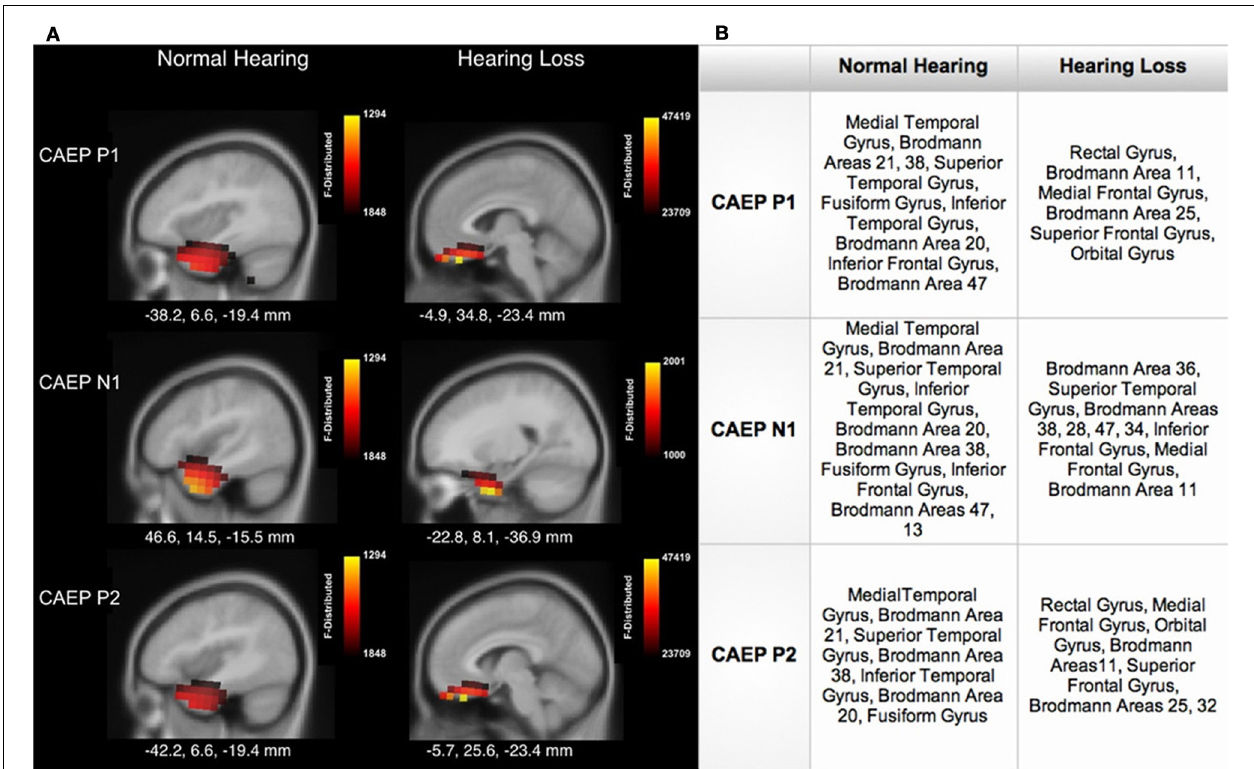
FIGURE 4 | (A) Current density reconstructions (CDR) showing cortical activation at the P1, N1, and P2 CAEP peak components on sagittal MRI slices for the normal hearing (NH) and hearing loss (HL) groups. The scale of the F Distribution is shown in the upper right corner ranging from red to